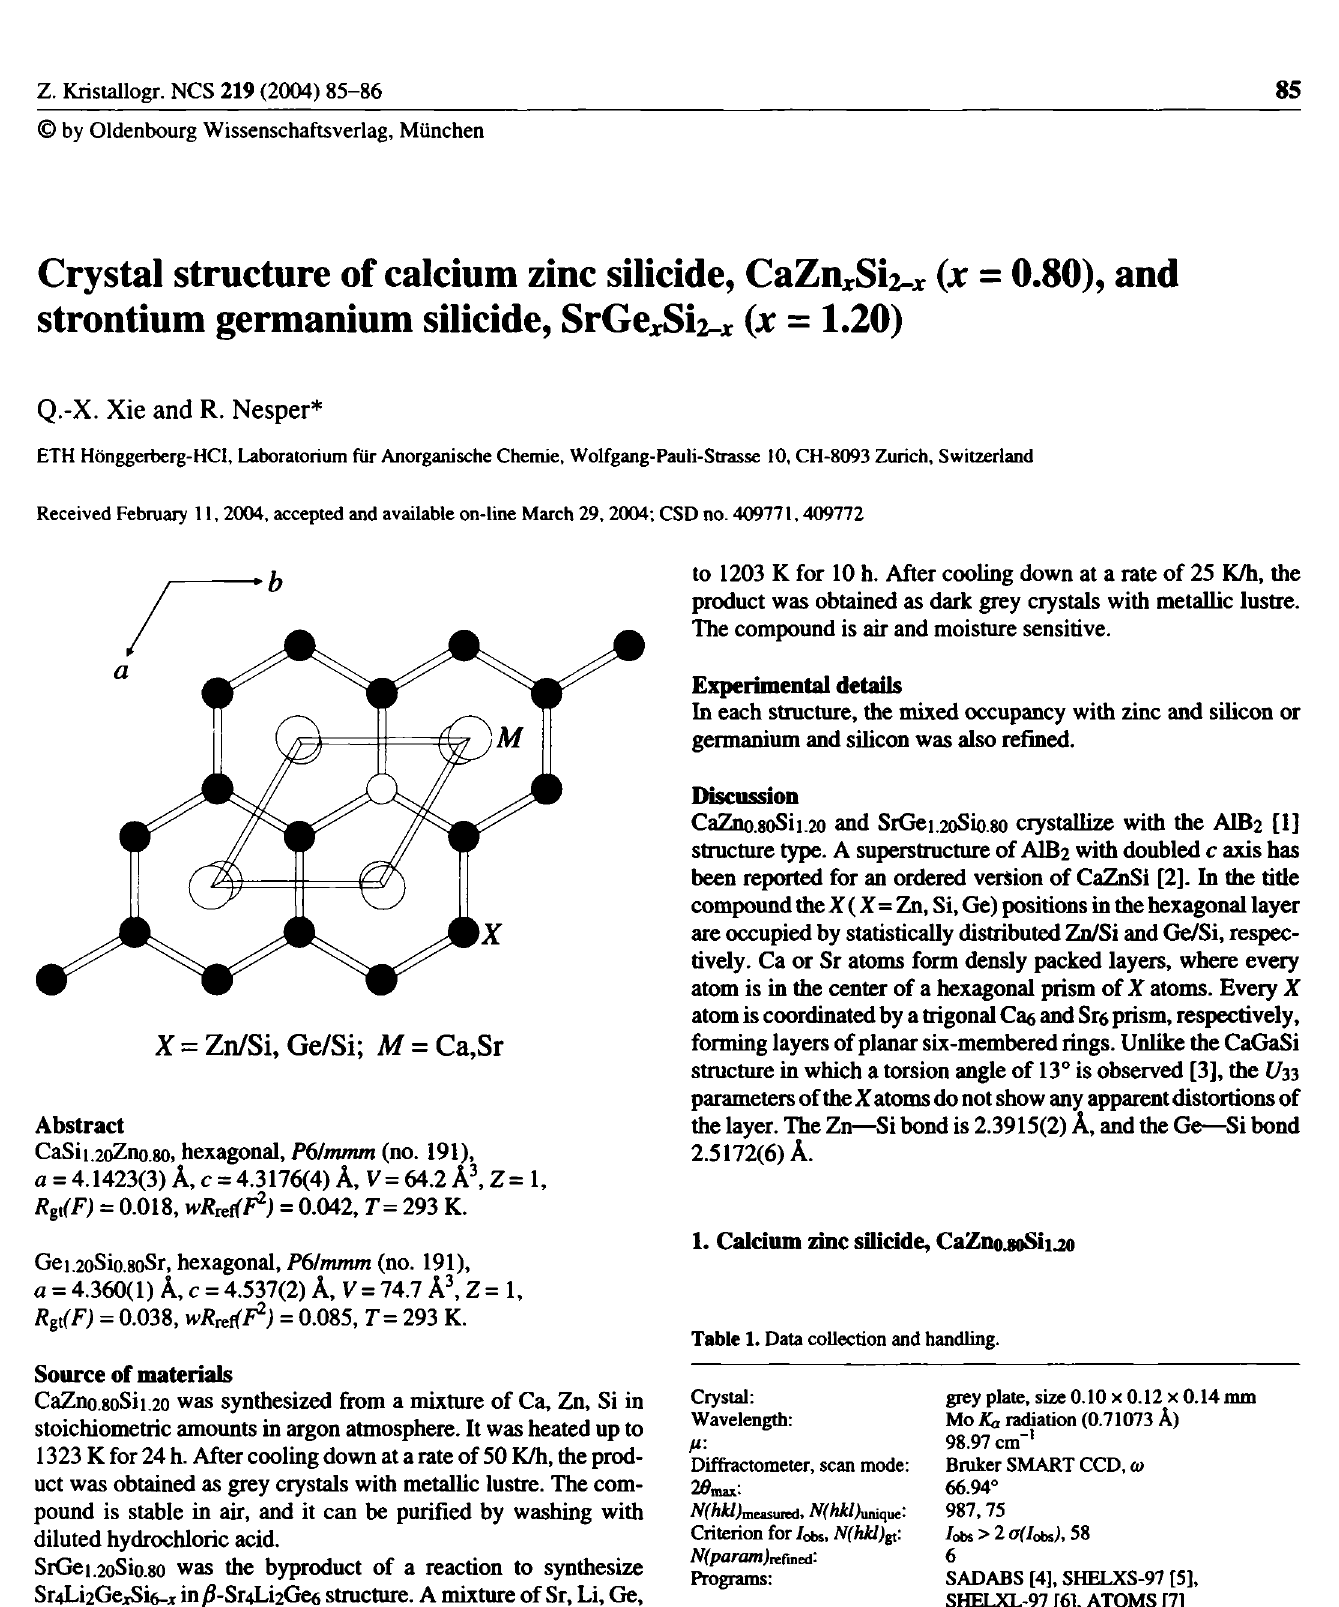
Table 1. Data collection and handling. Crystal: Wavelength: ft- Diffractometer, scan mode: